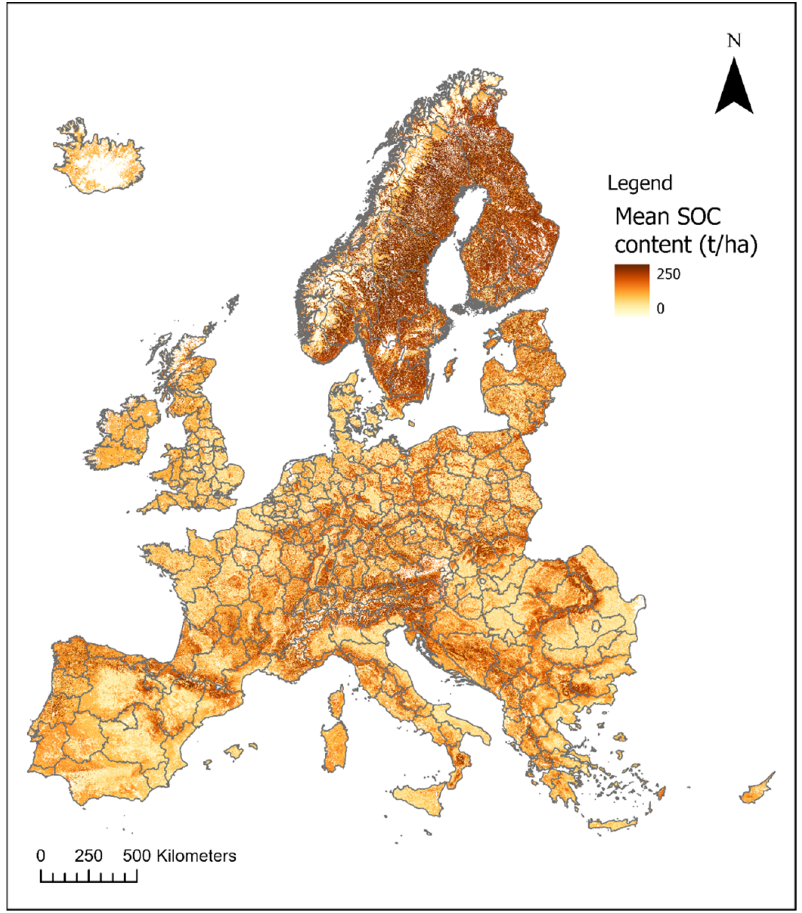
Figure 7. Simulated long-term average SOC stocks across Europe using the PESERA model.